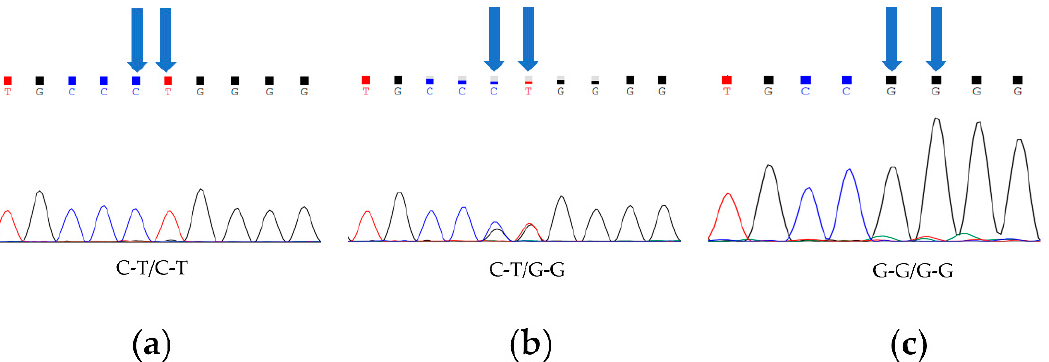
Figure 1. Three genotypes of TBXT in Barag sheep and short-tailed sheep. Blue arrows point to two polymorphic sites. ( a ) Fragments of chromatograms with genotype C-T/C-T. ( b ) Fragments of chromatograms for heterozygous genotype C-T/G-G. ( c ) Fragments of chromatograms with genotype G-G/G-G. Table 2. Genotyping statistics for Barag sheep and short-tailed sheep.